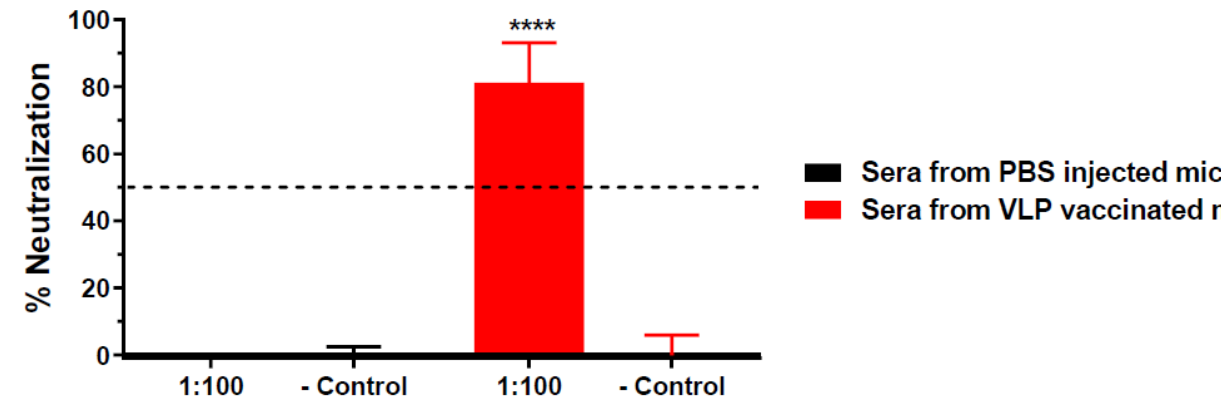
Figure 1. Neutralization of WNV by serum from HBcAg-wDIII VLP immunized mice. The neu- tralization potency against WNV of pooled sera from mice that were immunized with HBcAg-wDIII VLP (VLP) or mock-immunized with PBS collected at 5 week post-immunization was measured by a PRNT assay. Sera were diluted 100-fold and incubated with 10 2 PFU of WNV prior to Vero cell infection. Mean % neutralization and SD from two independent experiments with technical tripli- cates for each sample are presented. − Control: PBS buffer in the PRNT assay. **** indicates p values < 0.0001 of HBcAg-wDIII VLP-immunized sera compared to sera from PBS-inoculated mice.